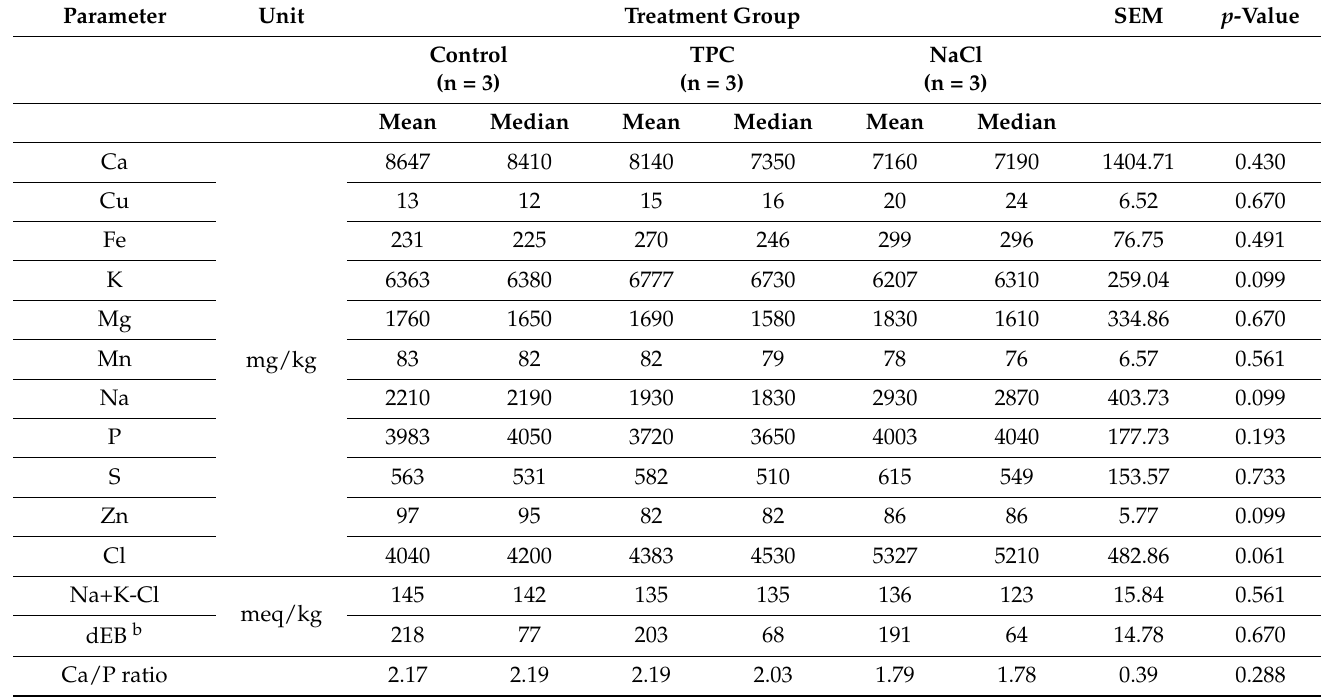
Table 2. Mineral composition a of the feed provided during the last weeks of the fattening period in each treatment group: the control group (control) received the normal feed used on the farm, the tripotassium citrate (TPC) and the sodium chloride (NaCl) groups received the normal feed supplemented with 0.25% TPC and 0.20% NaCl, respectively.